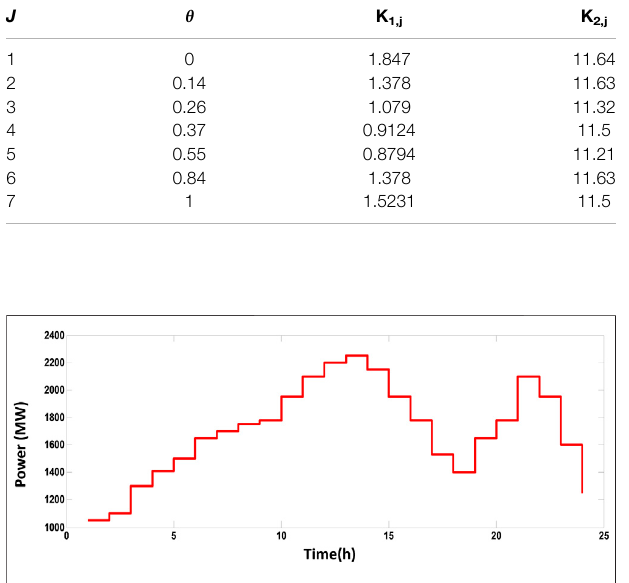
FIGURE 3 | Initial hourly load demand for case study 2 (Scenario